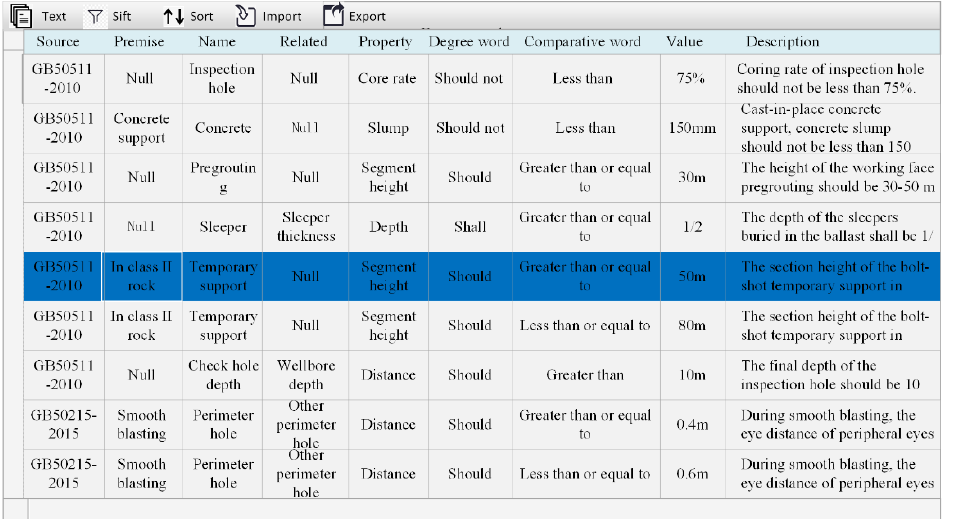
Figure 3. Rules database detail diagram.